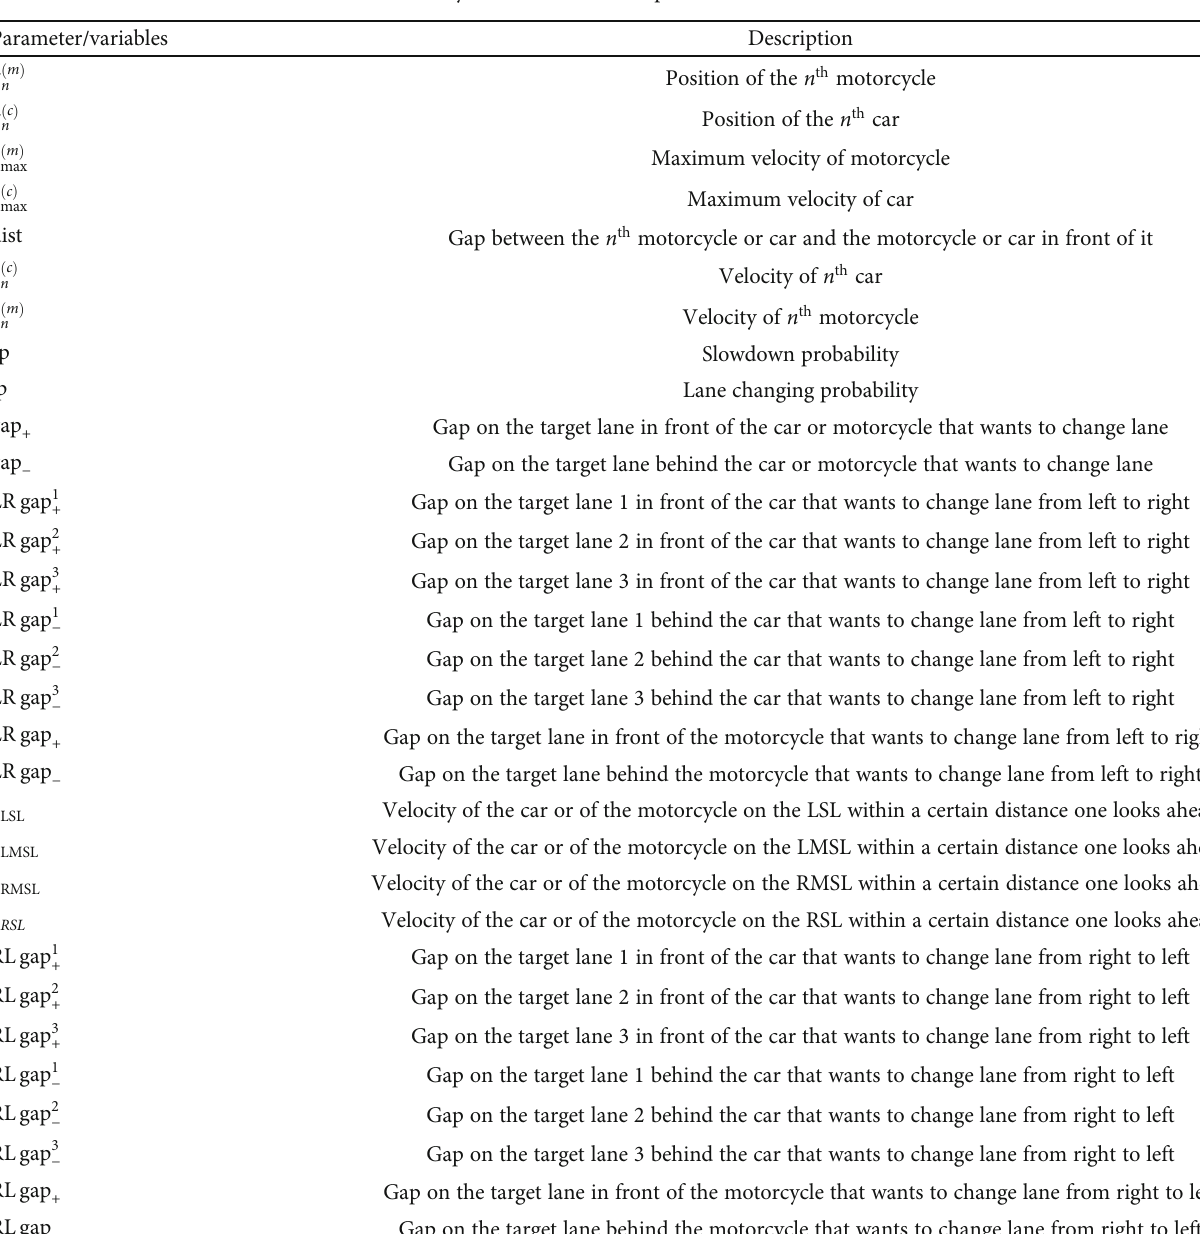
Table 1: Summary of the variables and parameters used in the